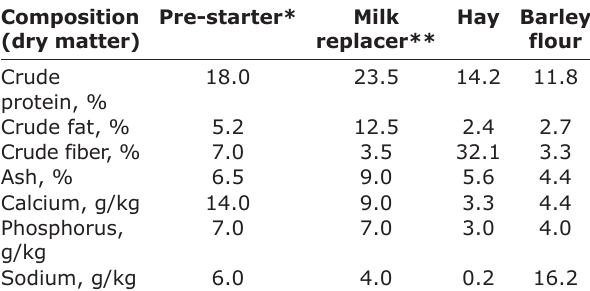
Table-1: Chemical composition of nutrients fed to calves during the study. Composition (dry matter)